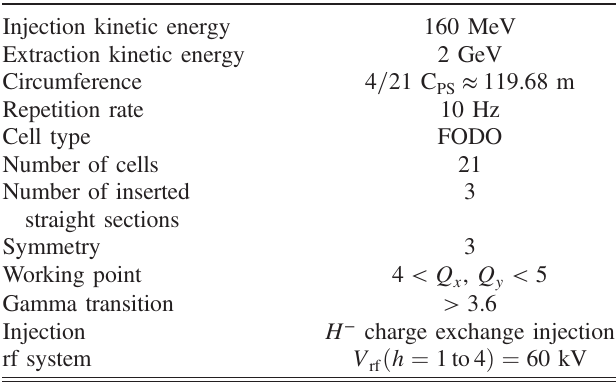
TABLE II. RCS parameters as proposed in the feasibility study [12].